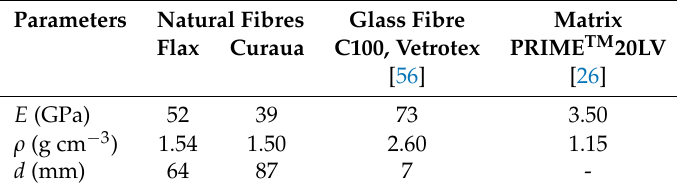
Table 4. Material properties used in the case